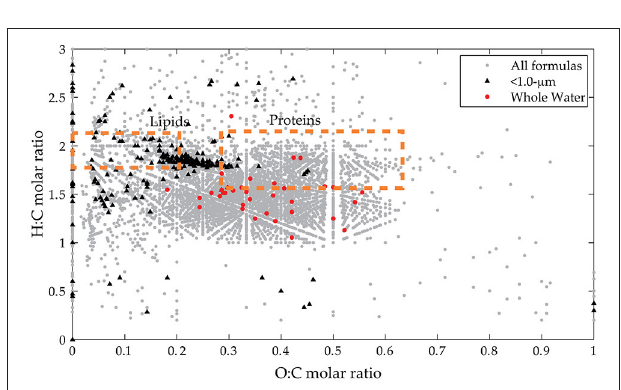
FIGURE 3 | Van Krevelen diagram for assigned formulas in all samples. Broad compositional classes are shown in boxes with all assigned formulas in all spectra (gray circles). Indicator peaks derived from presence/absence data are also shown ( < 1.0- µ m indicators in black triangles, whole water indicators in red